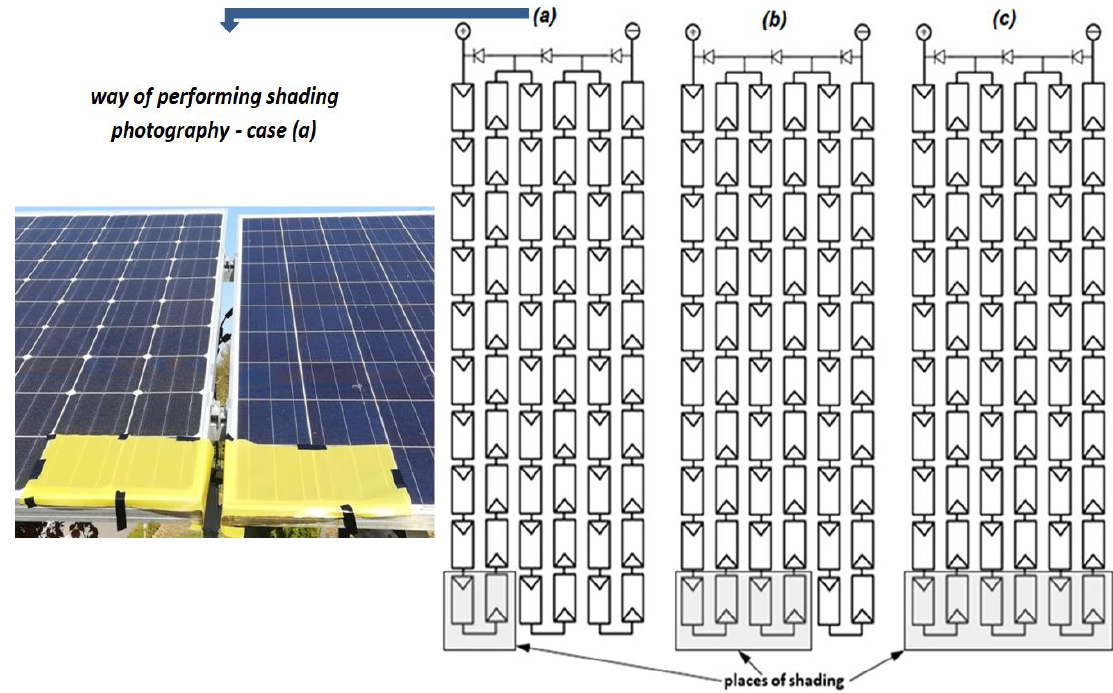
Figure 3. Diagram of the internal structure of typical silicon PV modules (60 pieces of PV cells) with marked spots of artificial shading of PV cells: ( a ) Two PV cells shaded (photography); ( b ) four PV cells shaded; ( c ) six PV cells shaded.